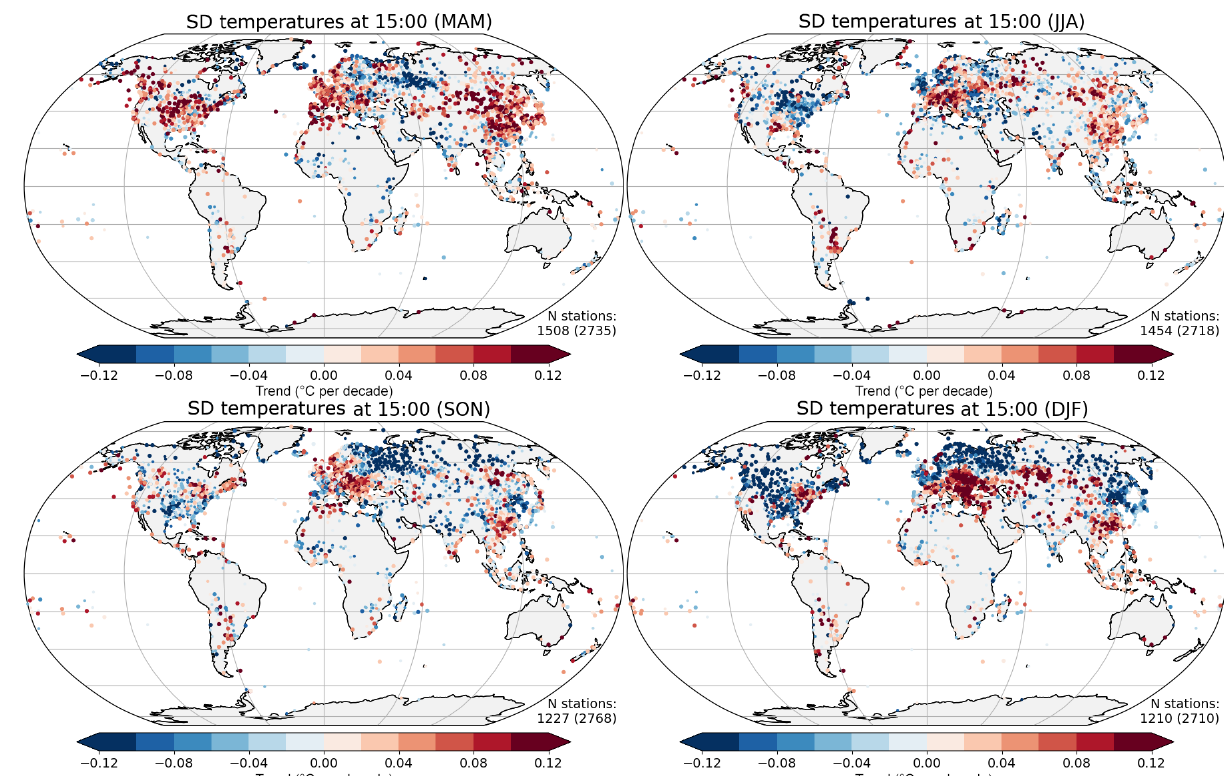
Figure 8. Trend over 1974–2018 in distribution standard deviation for temperature at 15:00LT across the four seasons. The stations where the 1 ˆ σ range of the fitted trend excludes zero are plotted with a larger symbol (the number of these is shown in the bottom right-hand corner of each plot). The total number of stations available is shown in